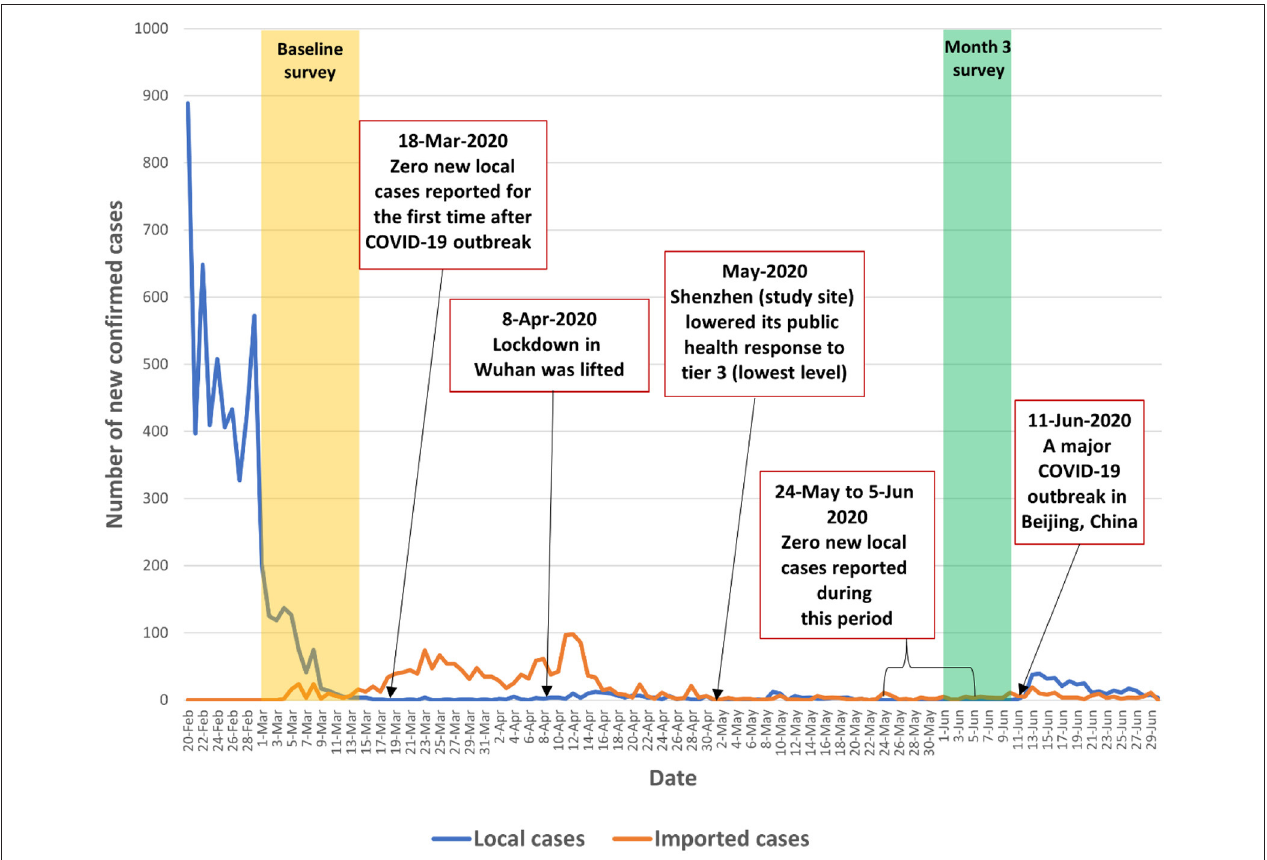
FIGURE 1 | Number of newly confirmed COVID-19 cases during the study period in